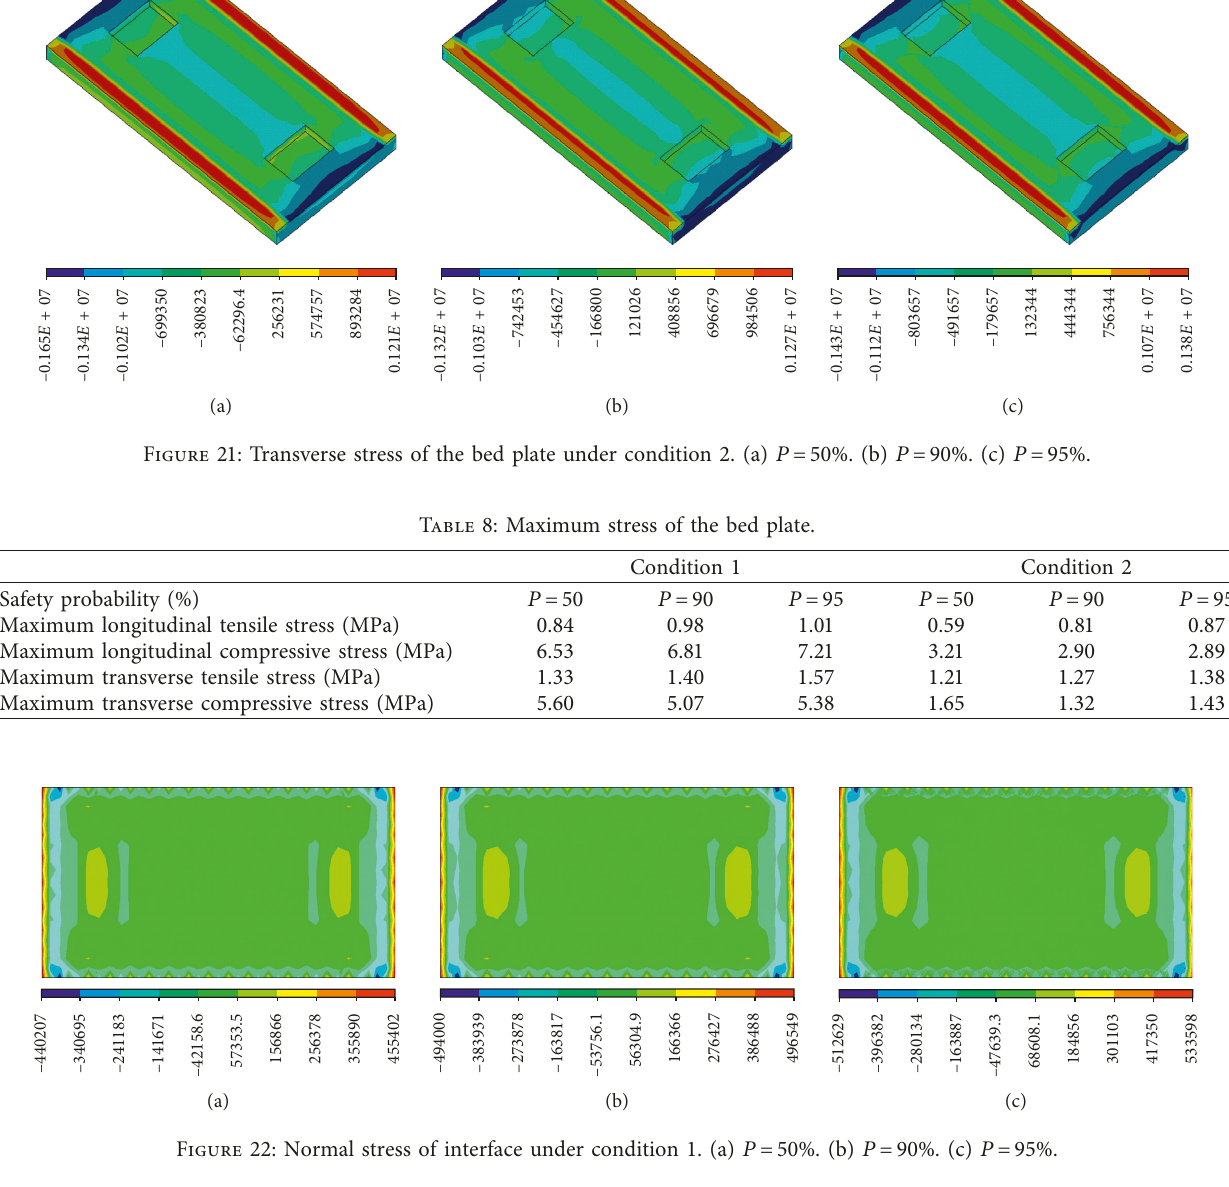
50%. (b) P 90%. (c) P 95%. (cid:31) (cid:31) (cid:31)